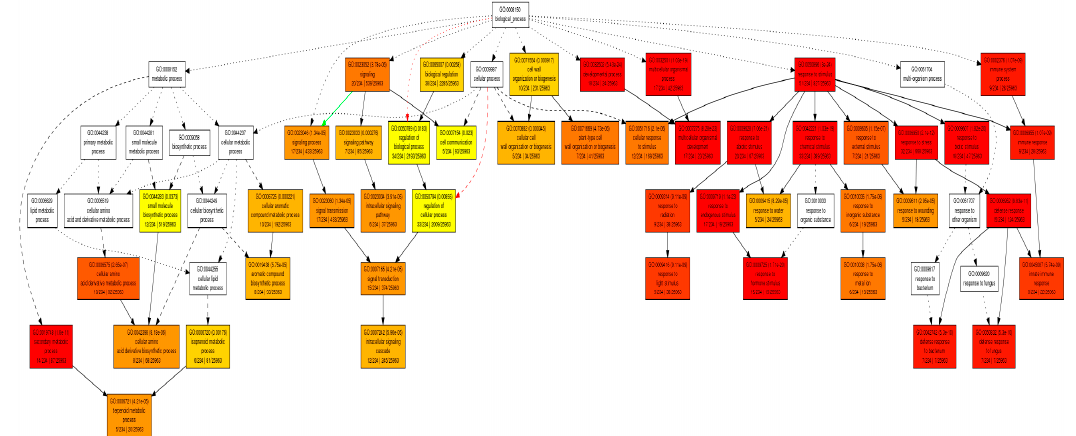
Figure 4. An interactive model of significantly enriched GO in transgenic plants.